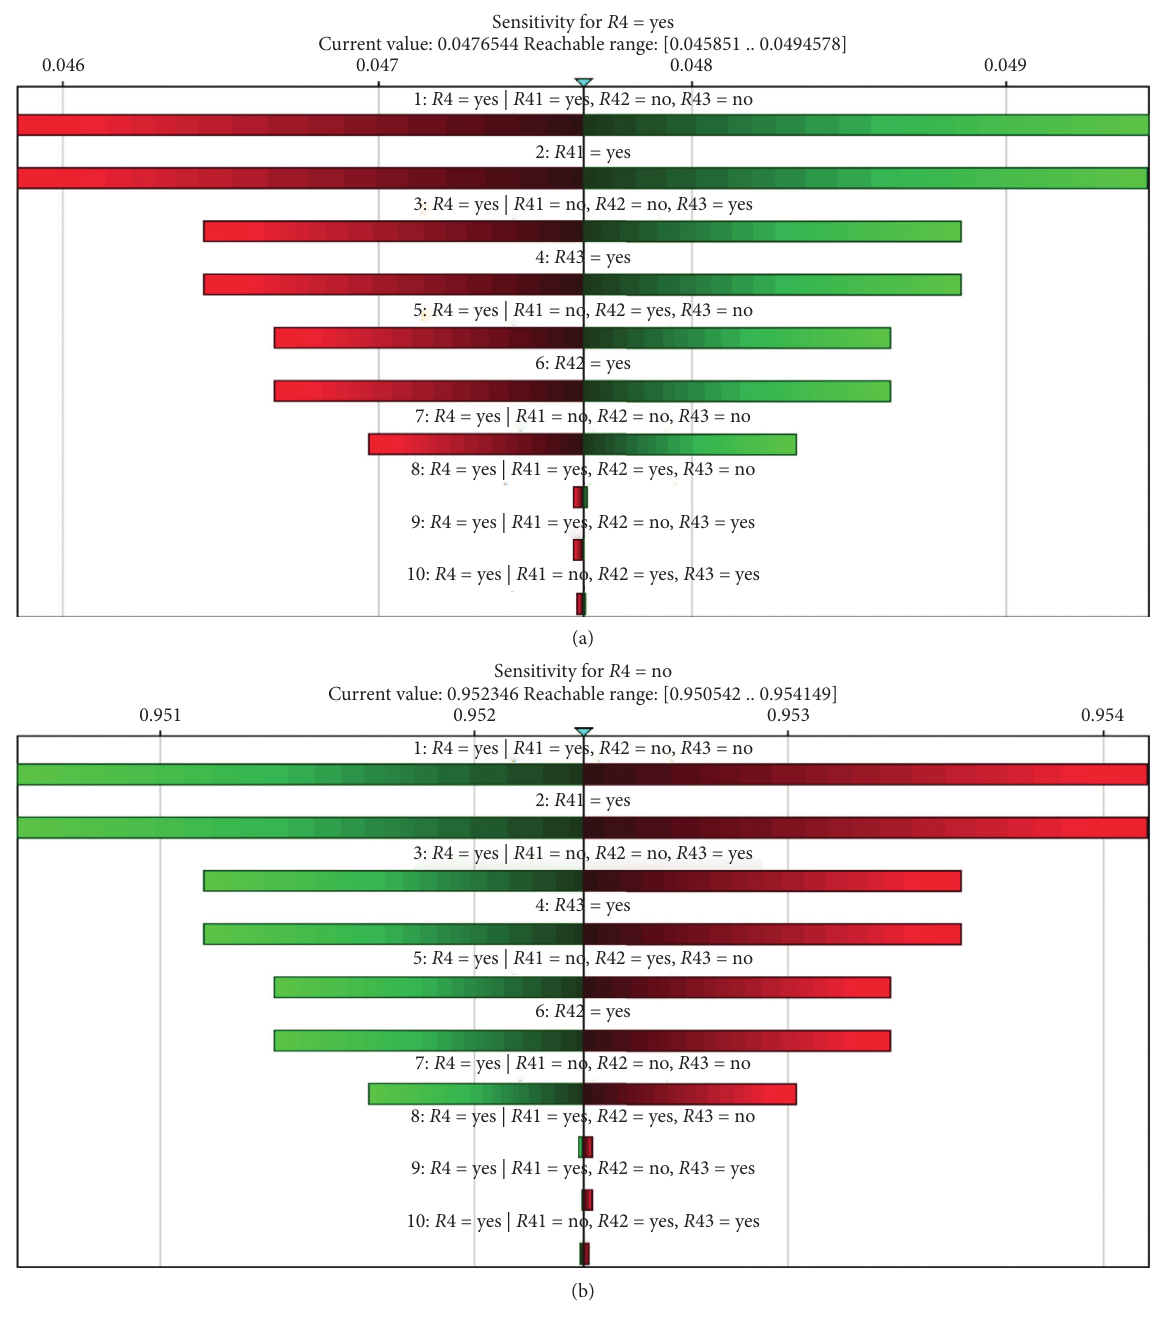
Figure 7: Sensitivity analysis of “capital resource risk ( R 4).” (a) R 4 � “yes” state. (b) R 4 � “no”